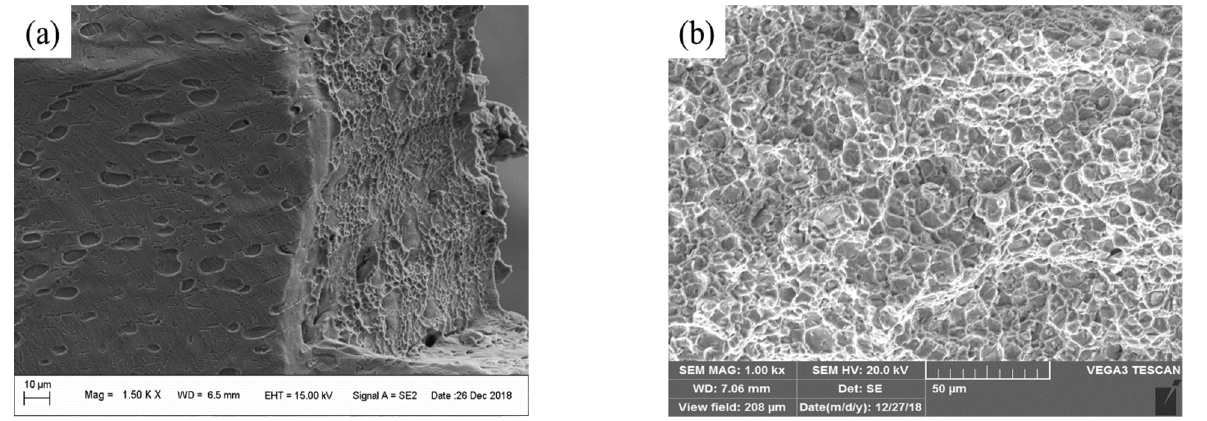
Figure 17. The SEM micrographs of the fracture morphology: ( a ) side view; ( b ) front view.